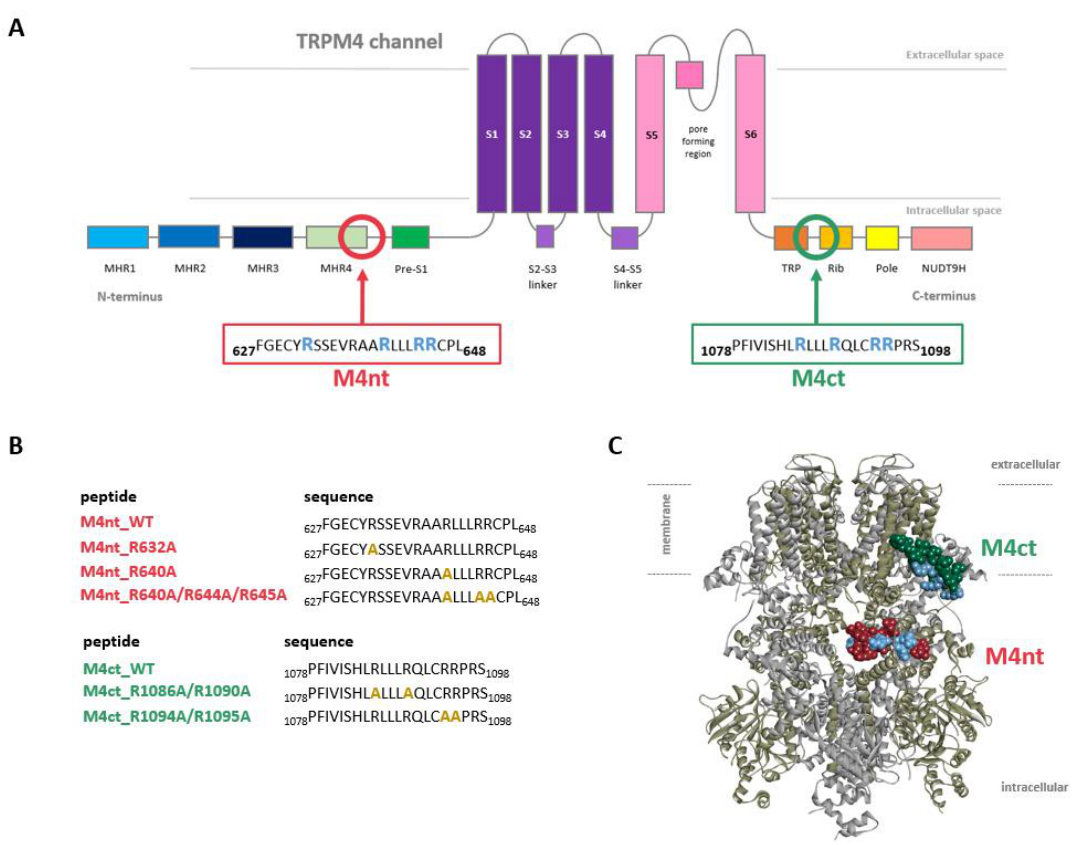
Figure 1. Localisation of transient receptor potential cation channel subfamily melastatin member 4 (TRPM4)-binding epitopes. ( A ) A scheme of the transmembrane topology and domain organisation of the TRPM4. The receptor is composed of six transmembrane helices (S1–S6, violet and pink), with a pore region between the 5th and 6th servers for the transport of monovalent ions (K + and Na + ). The MHR1–4 and pres-S1 (blue and green) show N-terminal modulatory domains. The Trp, Rib, Pole and NUDT9H (orange, yellow and pink) display the C-terminal modulatory domains. The predicted modulatory binding epitopes—N-terminal (M4nt and F627–L648, deep-pink frame) and C-terminal (M4ct and P1078–S1098, green frame)—display putative calmodulin (CaM), S100A1 and phosphatidylinositol 4, 5-bisphosphate (PIP 2 )-binding epitopes. ( B ) The peptide M4nt and M4ct wild types and their mutant forms synthesised from the designed TRPM4-binding epitopes. The gold alanine residues in the peptide sequences show the mutated positions of the original blue arginine residues. ( C ) The TRPM4 structure side view (6BQV) with M4nt (deep-pink ball representation) and M4ct (green ball representation)-binding epitopes; the blue highlighted (ball representation) arginines display the potential critical basic residues involved in ligand (CaM, S100A1 and PIP2) interactions. The opposite TRPM4 homomeric subunits are shown in the cartoon representation by grey and army colours.